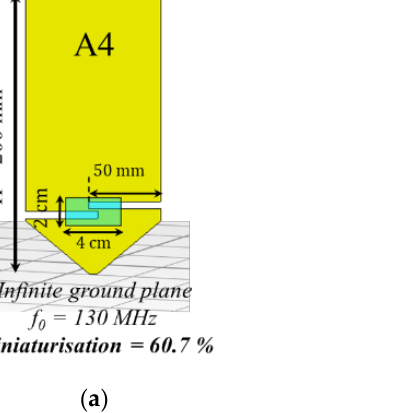
Figure 9. ( a ) Reduction rate of f 0 and μ eff in function of the slot ’ s length L slot . ( b ) Reduction rate of f 0 and μ eff in function of the slot ’ s height H slot .